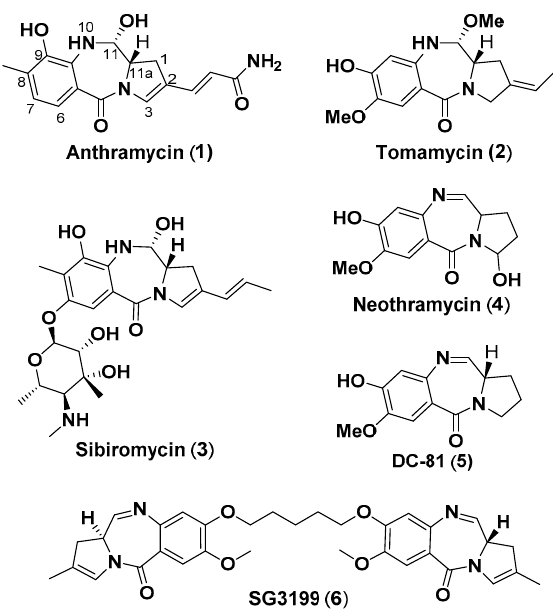
Figure 1. Structures of naturally occurring PBD monomers 1 – 5 and antibody–drug conjugate (ADC) warhead dimer 6 .